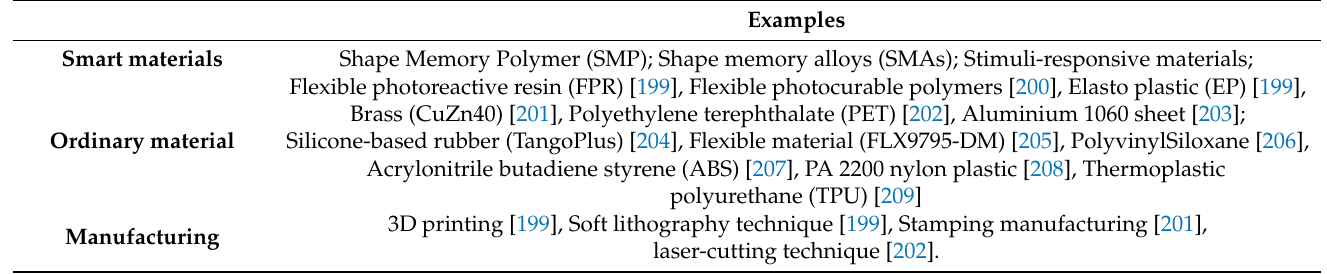
Table 4. Unit cells manufacturing elements.